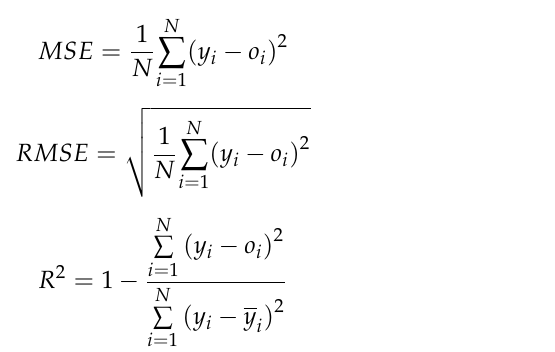
Figure 3. Output curve of ICSO-SVM model of nonlinear system.